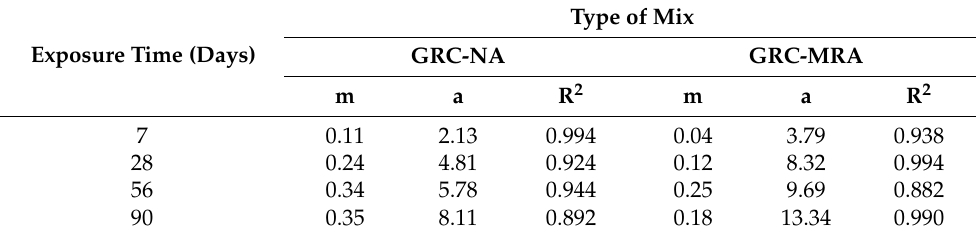
Table 7. Correlation between mean carbonation depth and GRC replacement